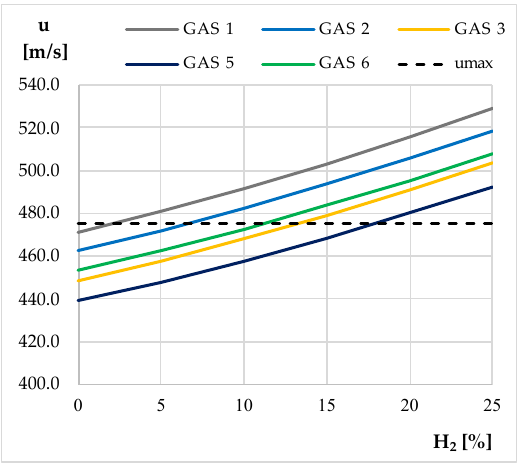
Figure 3. Trend of the sound speed as a function of the H 2 content in NG mixtures. Dashed line represents the applicable limit [23].